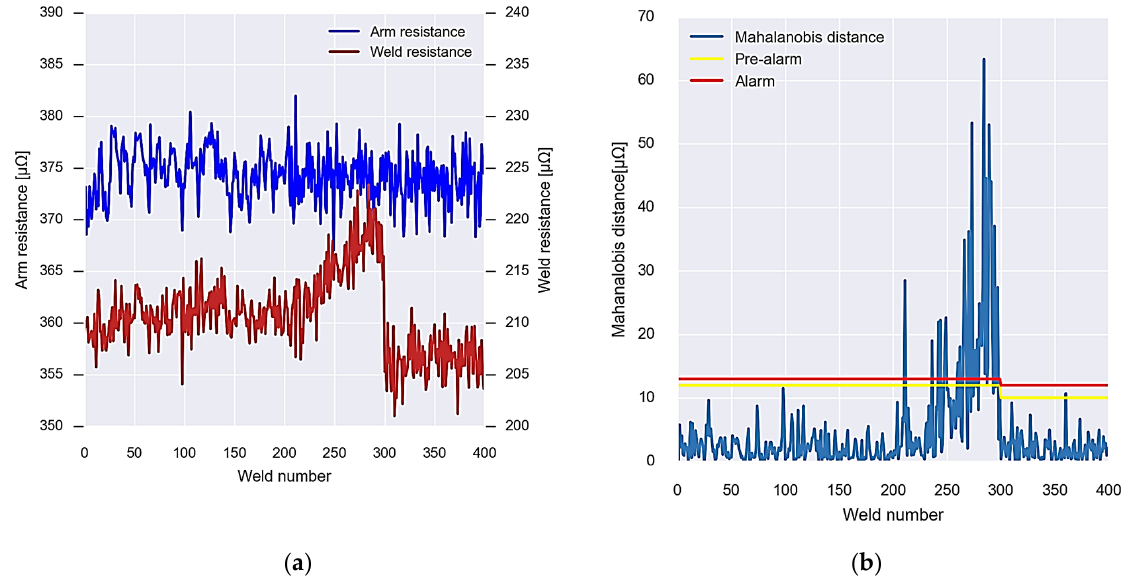
Figure 11. Graphic summary of the operation of the wear detection system algorithms. ( a ) Re- sistances obtained from the virtual sensor. ( b ) Calculated Mahalanobis distance and alarm and pre-alarm thresholds